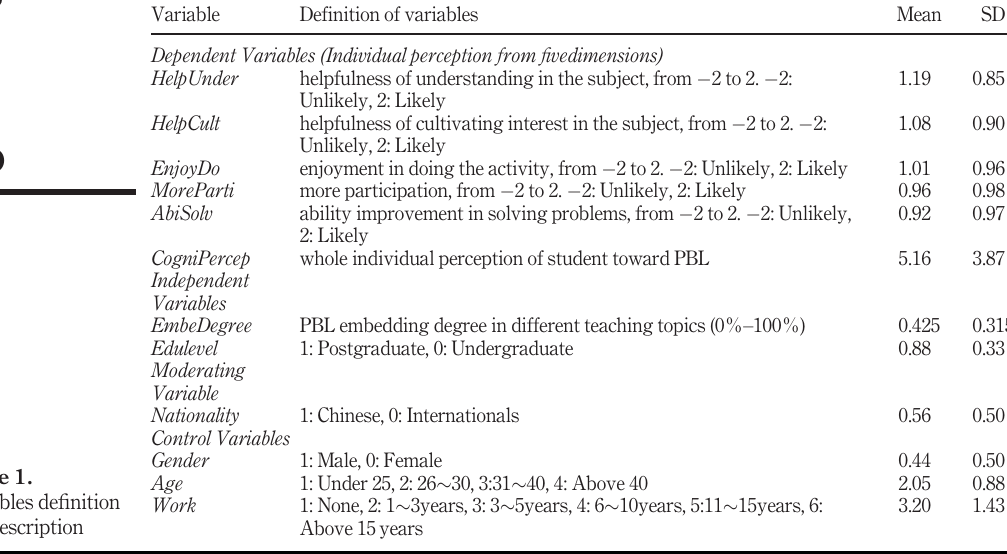
Table 1. Variables de fi nition and description